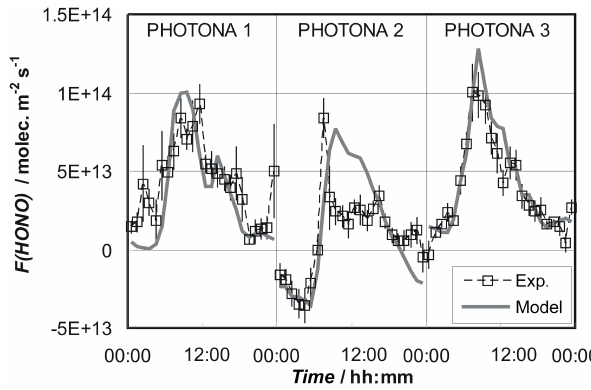
Figure 7. Diurnally averaged measured HONO fluxes in compari- son with modelled values (Eq. 8) during the three PHOTONA cam-